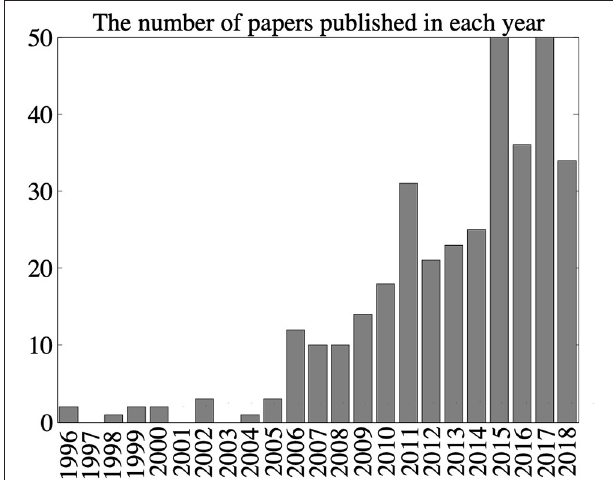
FIGURE 1 | The number of reviewed papers on event-based visual, auditory and olfactory systems in each year since